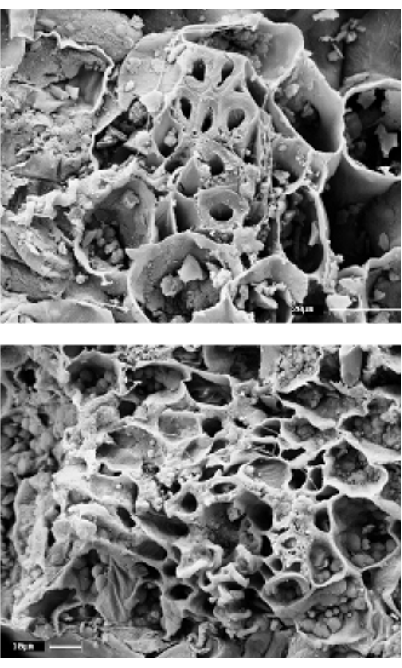
Figure 4. Secondary leaf veins of coffee grown in adequate top) and deficient (bottom) B nutrient solutions. Note disorganization of xylem vessels in deficient